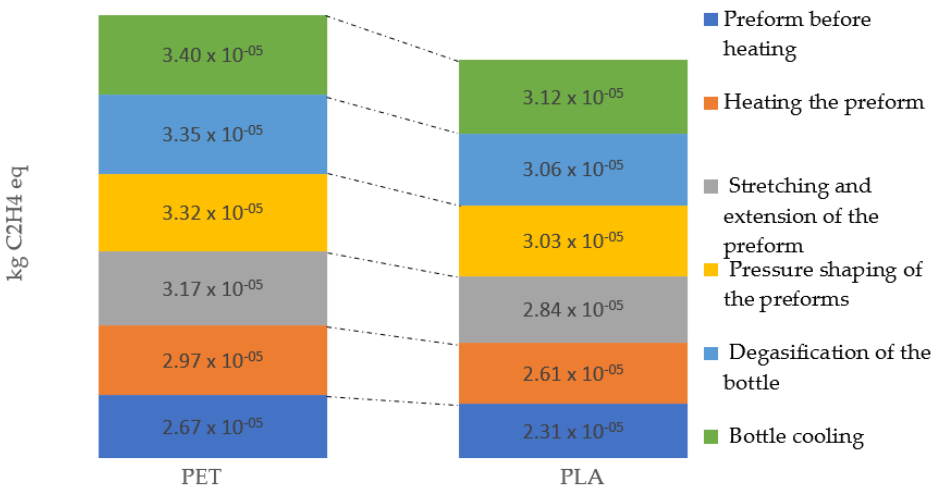
Figure 13. Photochemical oxidation emissions throughout the entire bottle shaping process. Human health and quality of life are closely related to the state of the environment. On the one hand, a good quality environment has a significant impact on both the physical and mental condition of man and on the state of social well-being, while on the other, its degradation and pollution can have a significant negative impact on health. DALY health condition is calculated as the sum of the Years of Life Lost (YLL) due to premature mortality in the population and the Years Lost due to Disability (YLD). Considering all life cycle operations of the PET and PLA bottle shaping process and its impact on human health, it should be stated that the highest potential impact was recorded for the cooling the bottle with compressed air PLA bottle operation at 7.13 × 10 − 8 DALY and PET bottle at 4.35 × 10 − 8 DALY (Figure 14). The reason for this is the share of tap water at the